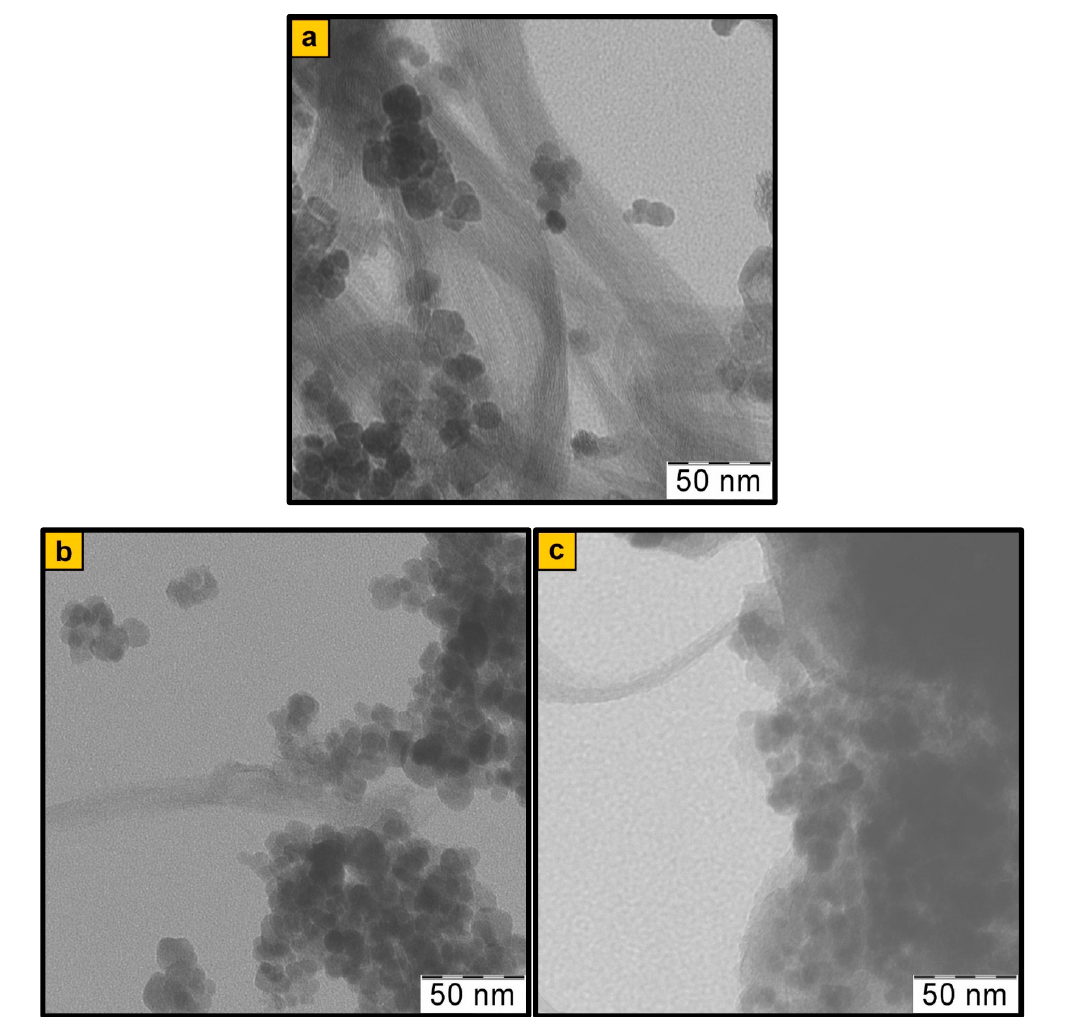
Figure 4. TEM images of Fe 3 O 4 / SWCNT ( a ) and Fe 3 O 4 / SWCNT / PDPAC, prepared in alkaline ( b ) and acidic media ( c ).